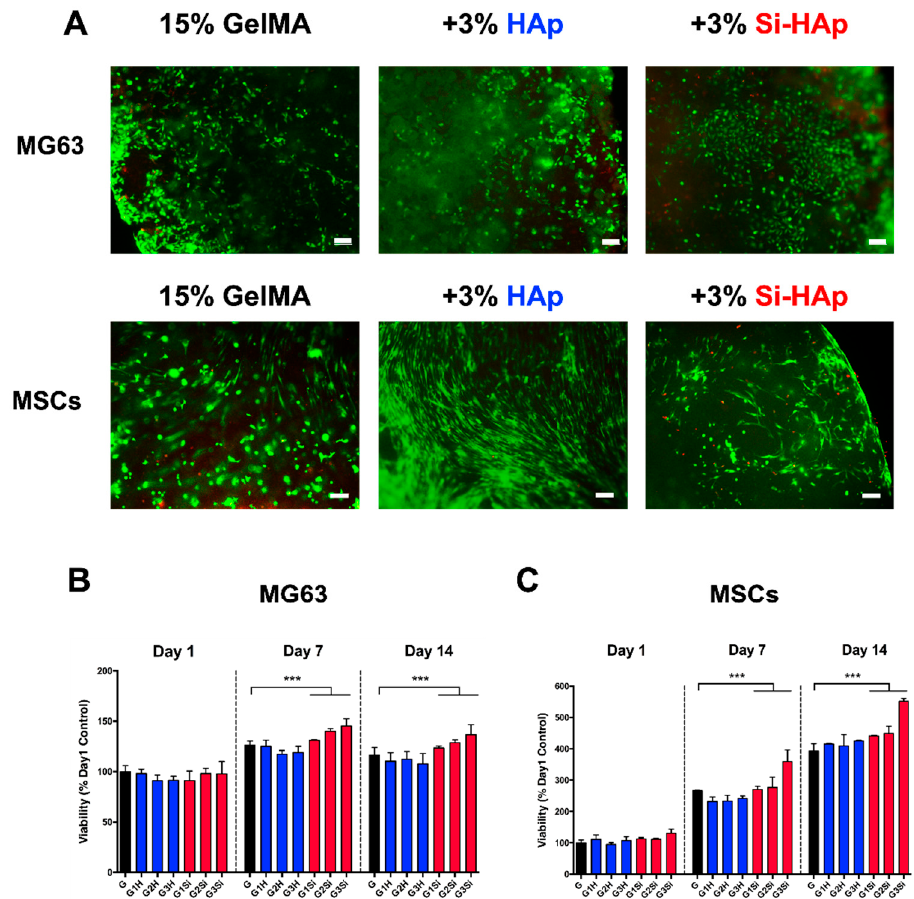
Figure 4. MG63 cells and human mesenchymal stem cells (MSCs) encapsulation by GelMA composite hydrogels. ( A ) Live/dead cell viability assay of human MG63 cells and MSCs on day 14. green, calcein AM, red, ethidium homodimer-1. Scale bar, 100 µ m. ( B ) MTT assay of human MG63 cells on day 1, day 7, day 14. ( C ) MTT assay of human MSCs on day 1, day 7, day 14. (G: 15% GelMA, G1H-G3H: 15% GelMA with 1–3% HAp, G1Si–G3Si: 15% GelMA with 1–3% Si-HAp). *** p < 0.001.